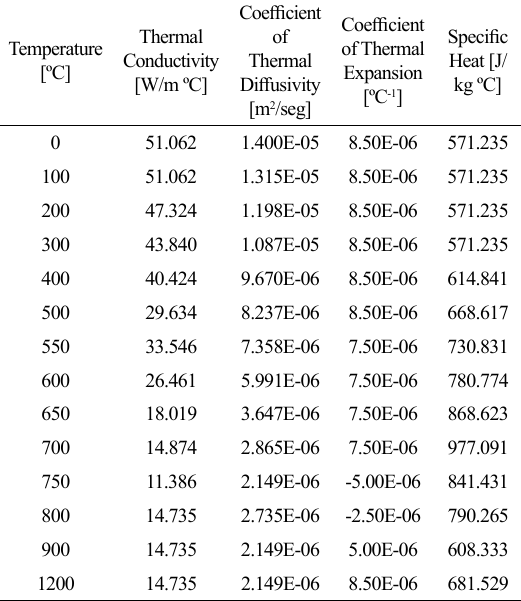
Figure 3. Macrography of the API 5L X80 steel welded joints, after a nital acid attack at 5% and an increase of 13 X Table 4 shows the geometric parameters of the Goldak heat source used in the work.